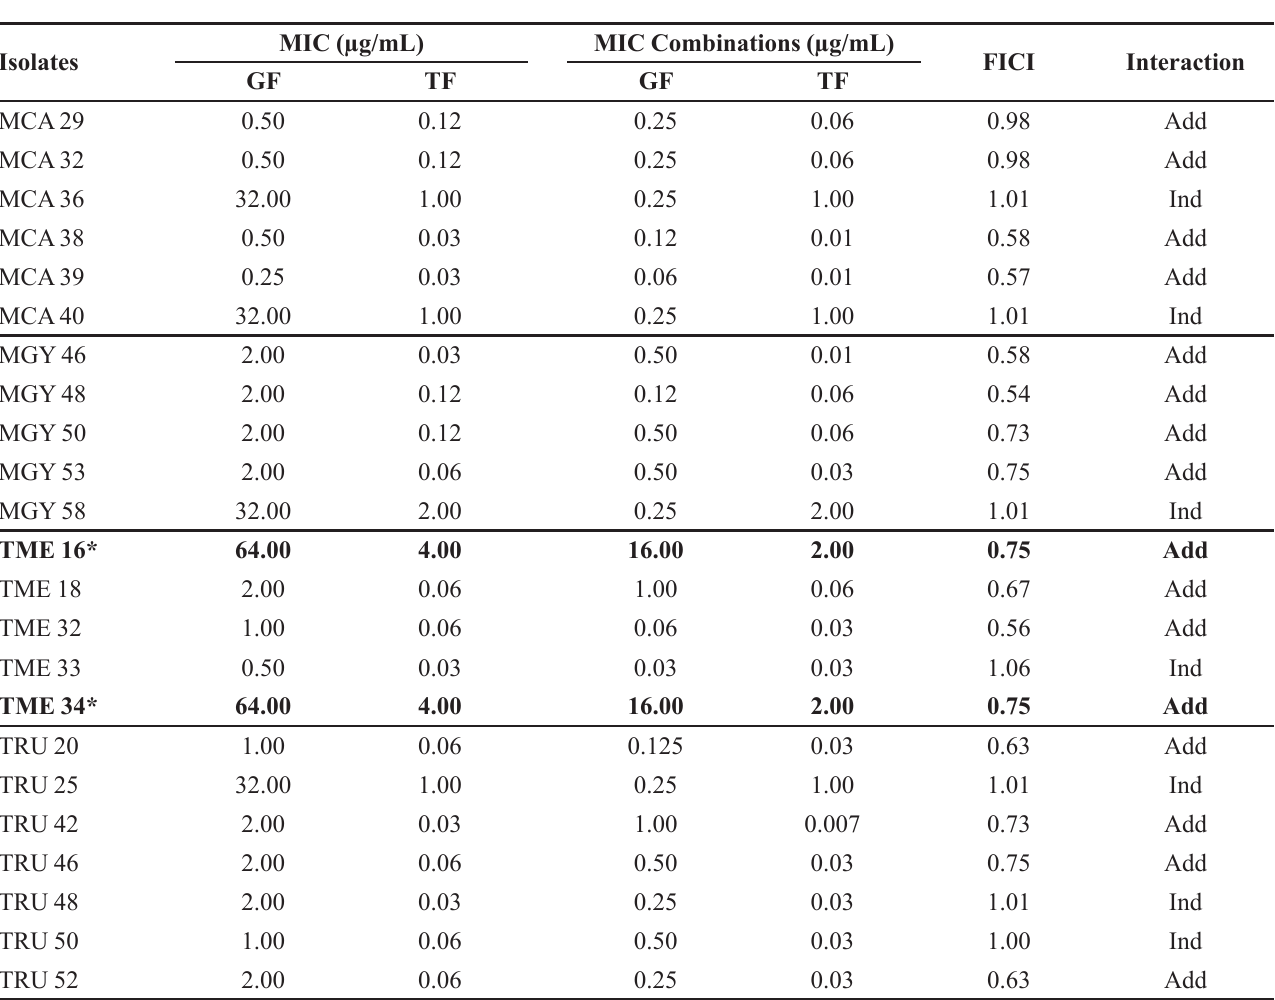
TABLE II - Fractional inhibitory concentration index (FICI) and type of interaction obtained for hyphae by testing GF:TF combinations according to the checkerboard microdilution method (qualitative methodology)